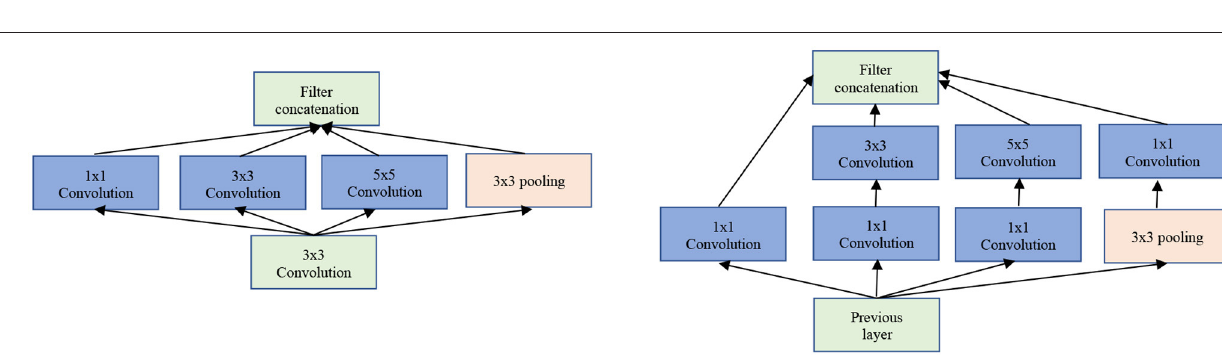
FIGURE 4 | Residual block of the ResNet algorithm (left) and the ResNet 12 architecture (right).